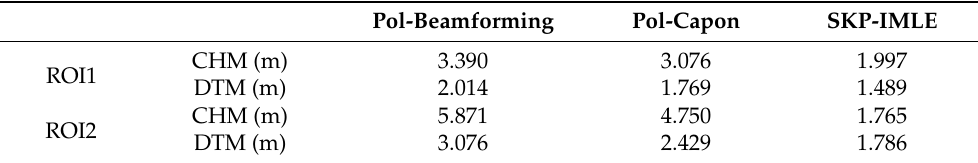
Table 3. Quantitative comparison of the employed methods with respect to LiDAR